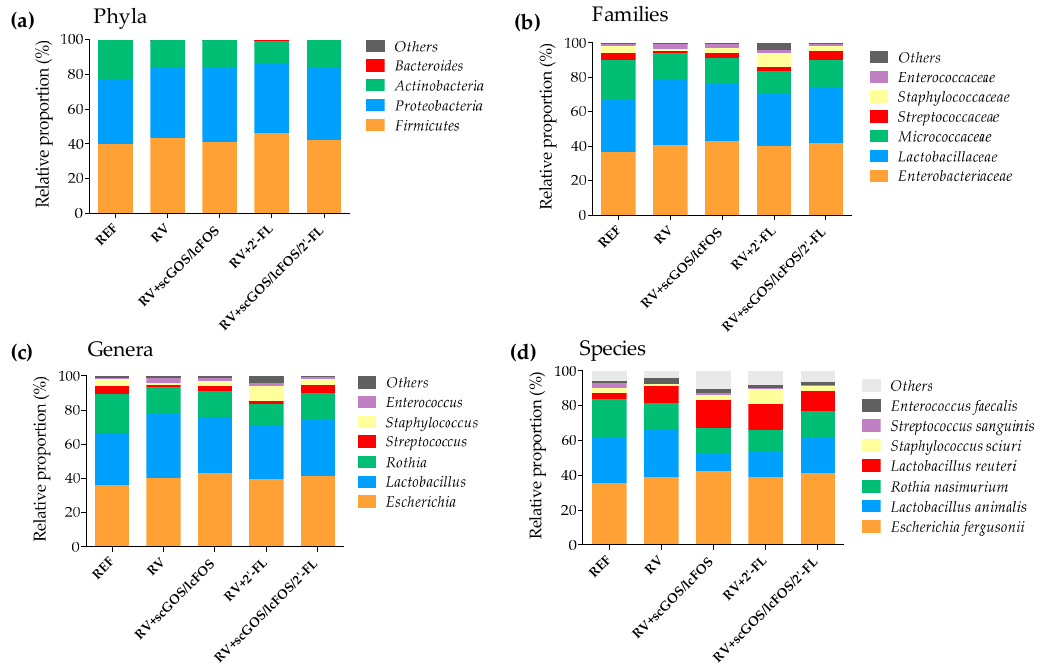
Figure 3. Main taxonomic ranks showing the proportion of bacterial populations in the fecal content at the peak of diarrhea (day 8): The sequencing of the amplicon targeting the V3–V4 region of the 16S rRNA was performed following the 16S Metagenomic Sequencing Library Illumina 15044223 B protocol. The relative proportion of the bacteria was calculated in each taxonomic rank: ( a ) phylum, ( b ) family, ( c ) genus, and ( d ) species. The results are expressed as mean (n = 3 / group). Significant differences are shown only in the text (by the Mann–Whitney U test).